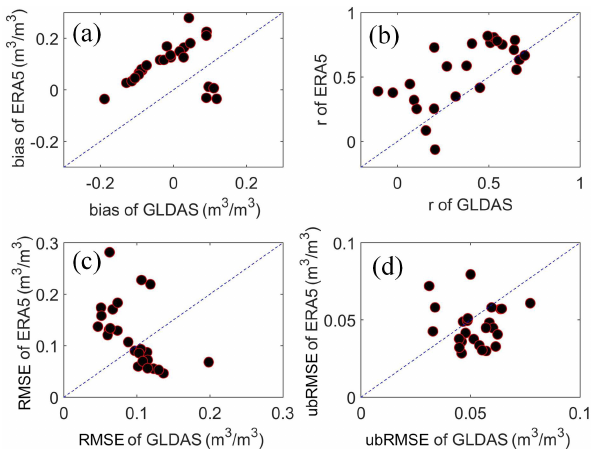
Figure 2. Comparisons of the (a) bias, (b) Pearson correlation co- efficient ( r ), (c) root mean square error (RMSE), and (d) unbiased RMSE (ubRMSE) for GLDAS and ERA5 soil moisture in the sum- mer period of May–September over 2008–2014 based on the soil moisture measurements from the